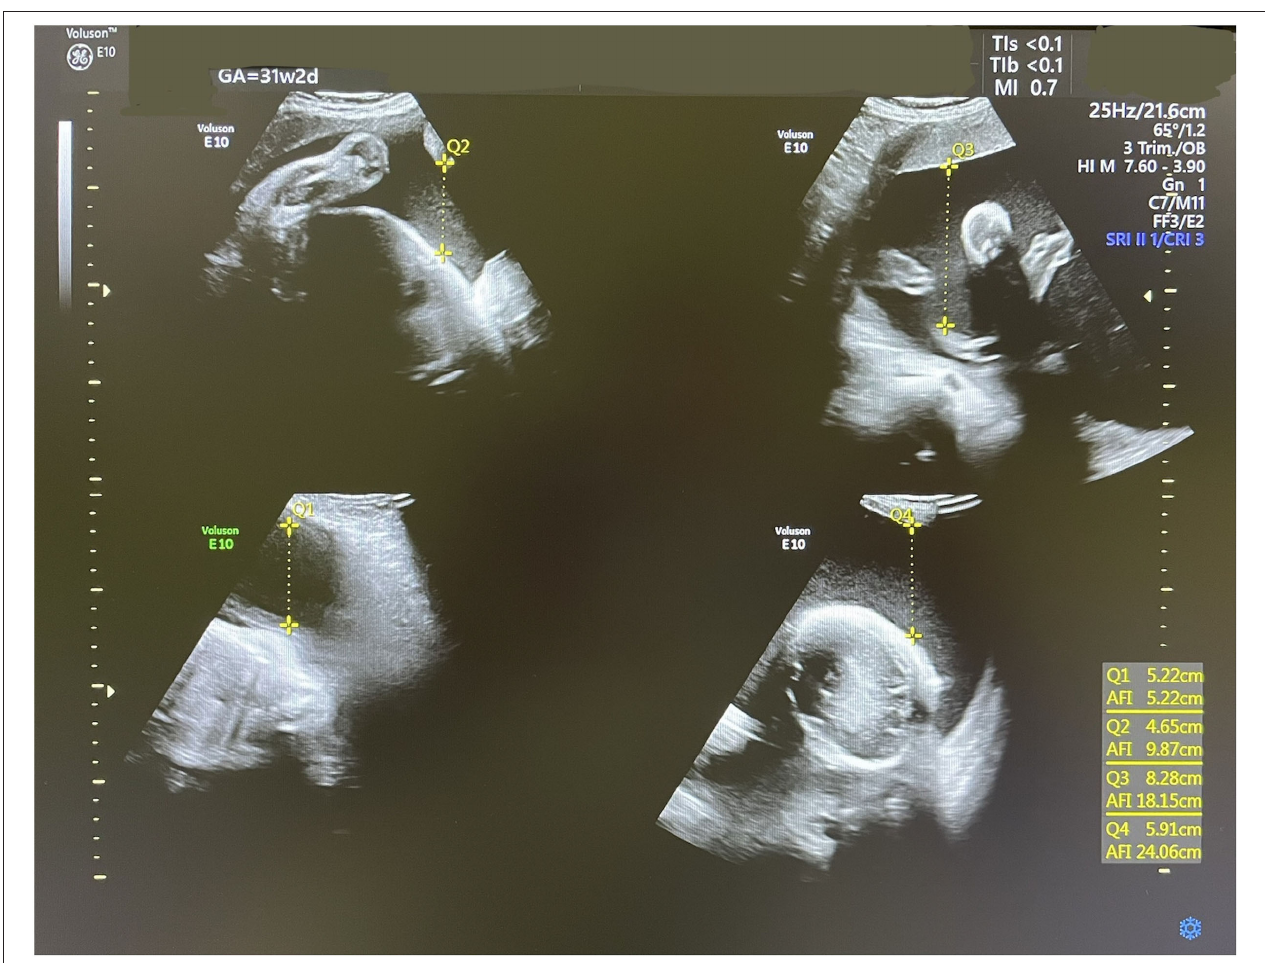
FIGURE 2 | An ultrasound scan showing an AFI of 24.1 cm at 31 weeks 2 days.